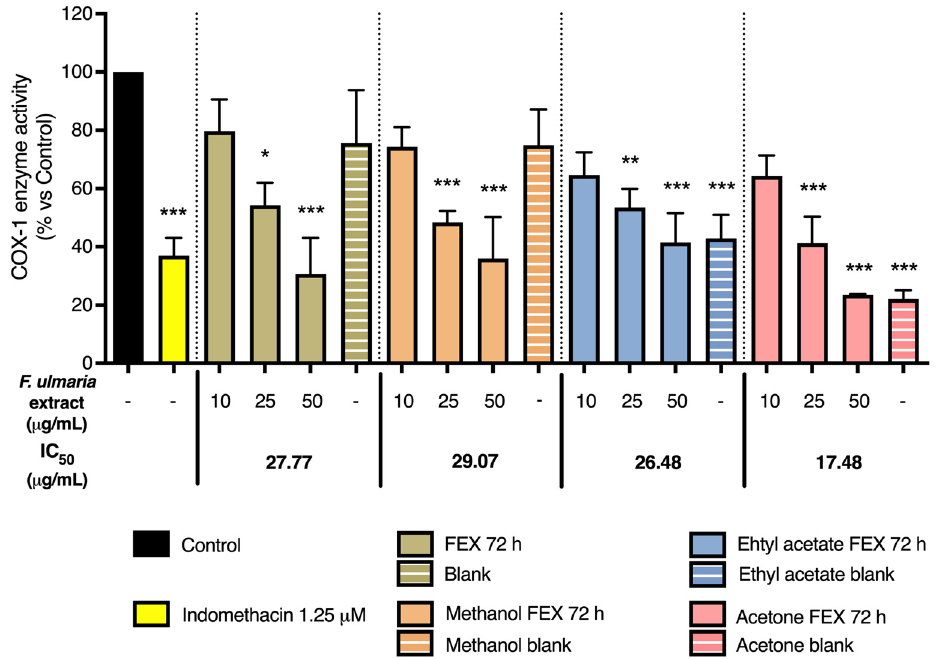
Figure 10. The effect of the digested F. ulmaria extract (FEX 72 h) and different extraction procedures of FEX 72 h on COX-1 enzyme inhibition. Indomethacin (1.25 µ M), in yellow, served as positive control. The graph depicts compiled data of three independent experiments (mean ± SD). p -values are expressed as * p < 0.05, ** p < 0.01 and *** p < 0.0001 compared to control. Table 2. IC 50 of digested F. ulmaria extract on COX activity. Digested F. ulmaria Extract